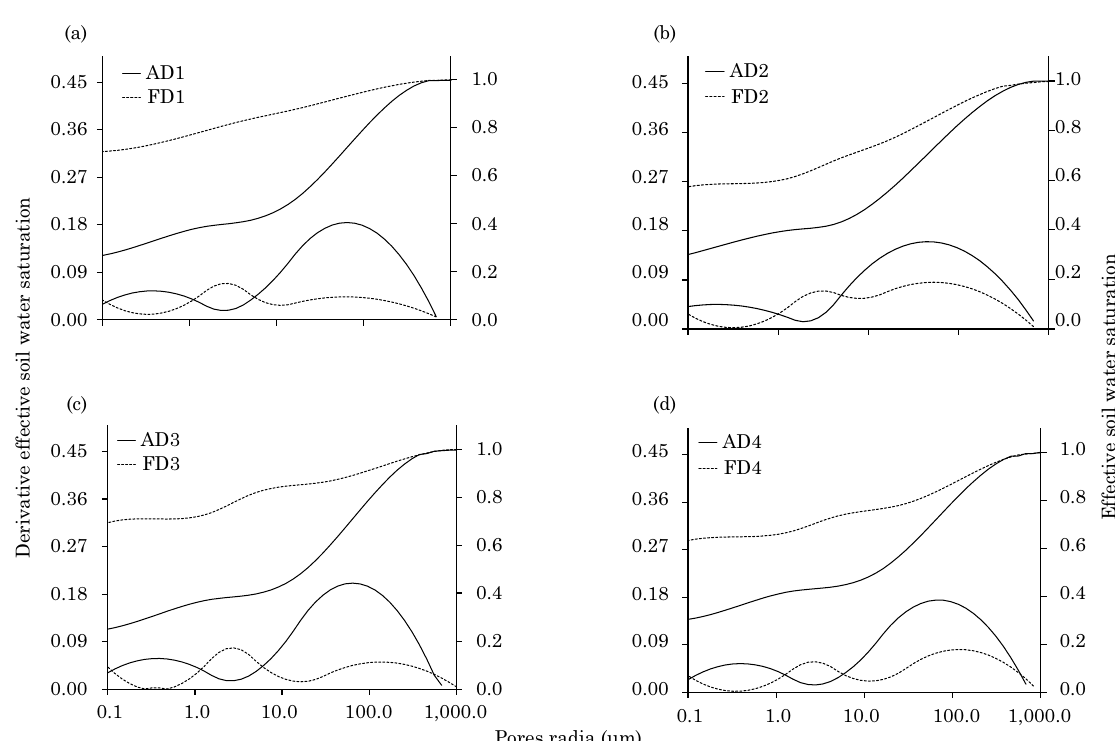
Figure 6. Effective soil water saturation (S e ) curves versus water pressure head (h) and contrasting pore size distributions (PSDs) under the continuous arable (A) cropping system and the natural bush fallow (F) system for depths D1 (0-5 cm) (a), D2 (5-10 cm) (b), D3 (10-15 cm) (c) and D4 (15-20 cm)